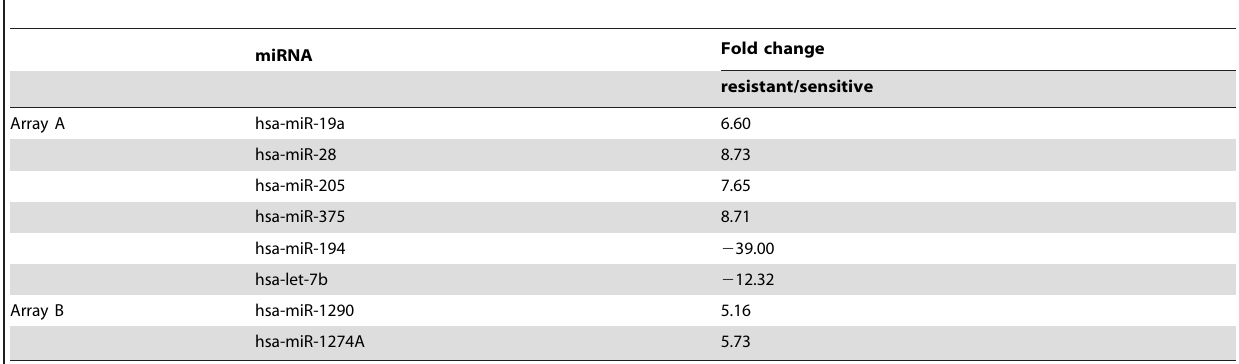
Table 2. Eight miRNAs with significant differences between the resistant and sensitive